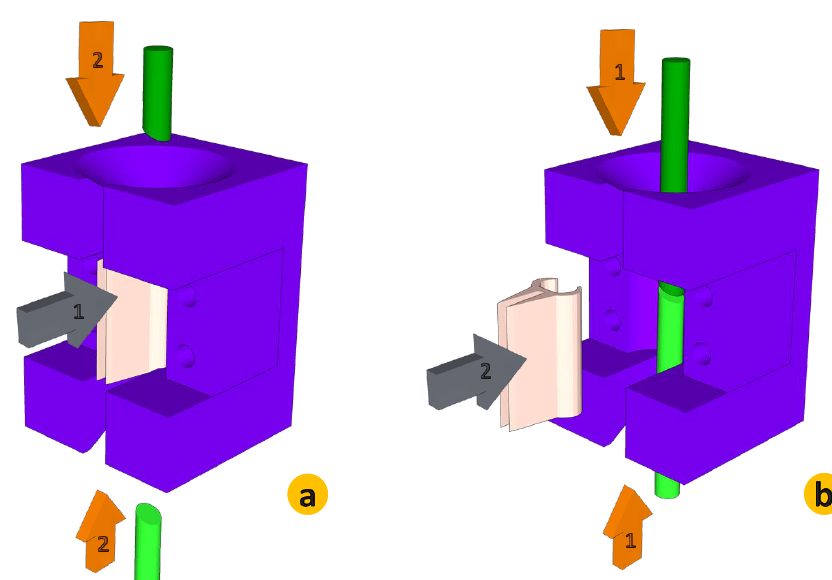
Figure 4. Passive fitting device, with seedlings (rootstock and scion) and the grafting clip at the graft union point. This piece allows the assembly operation, where the two robots and the clip dispensing device consummate the graft. ⓐ First placement of the grafting clip, and then splice of the seedlings (CS). ⓑ First splice of the seedlings, and then placement of the grafting clip (SC). For each of the grafting-order alternatives, three combinations of the seedling surface orientation were tested with respect to the grafting clip opening (Figure 5):